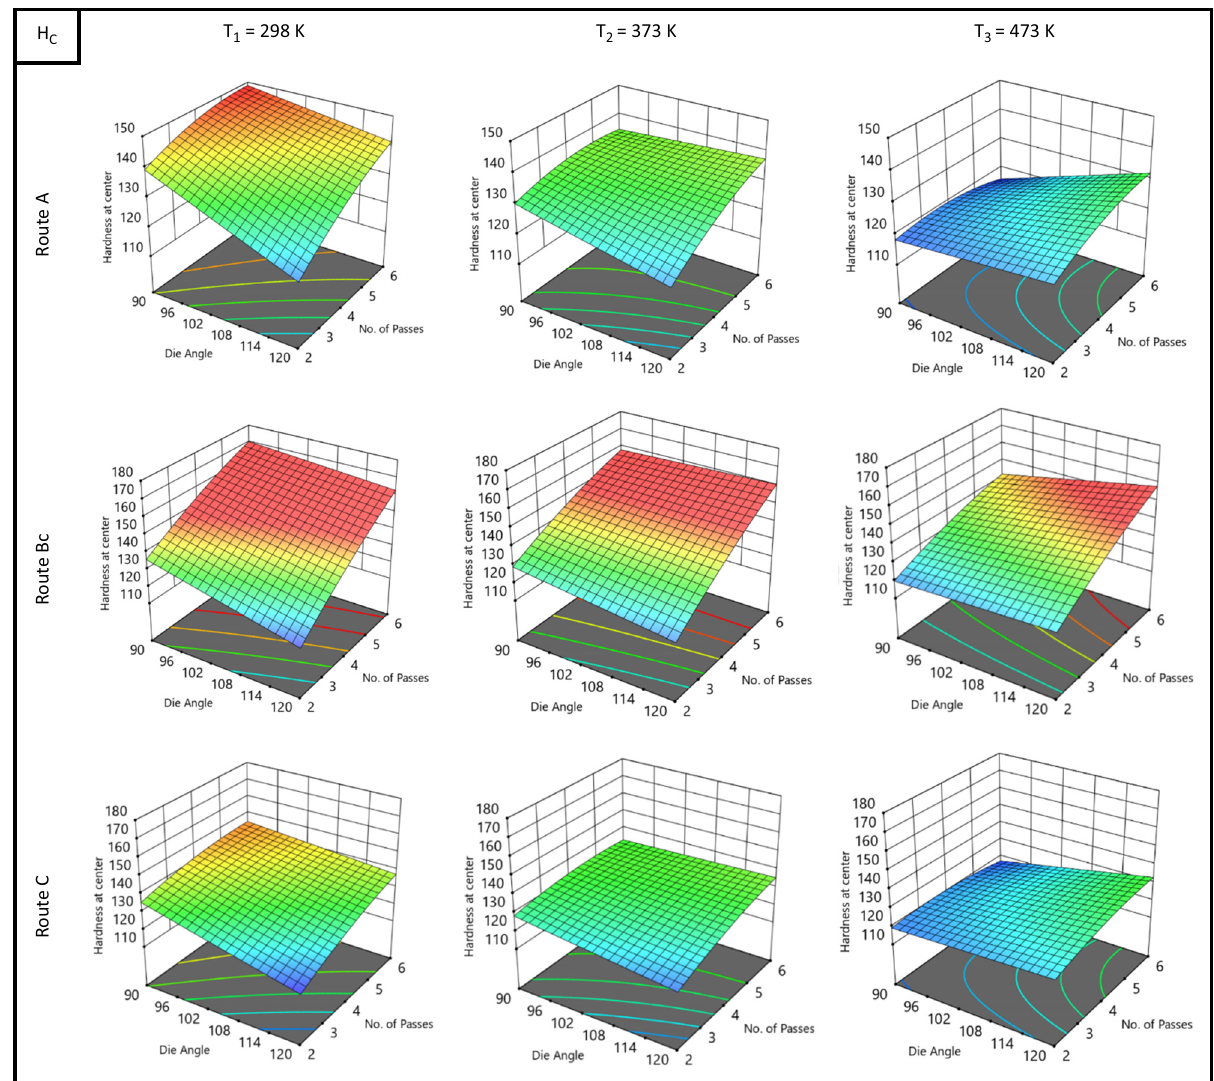
Figure 12: Response surface plot of H C as a function of die angle, number of passes, route type, and processing